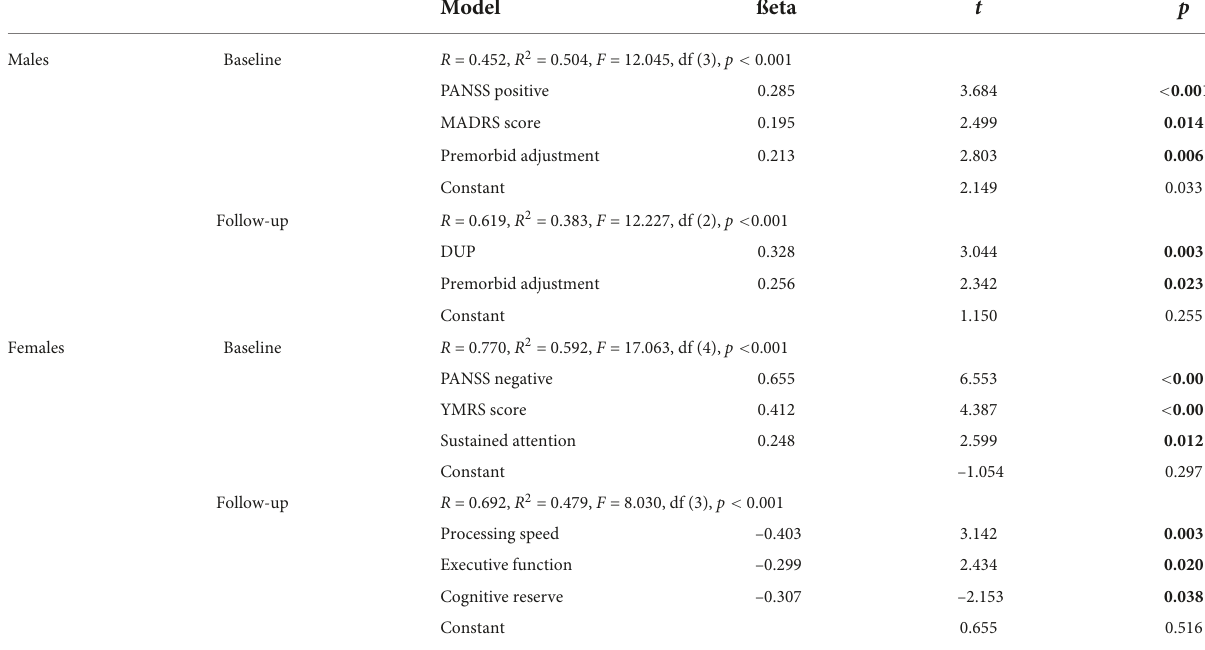
TABLE 4 Linear regression of the socio-demographic, clinical and neuropsychological variables associated with psychosocial functioning in males and females with psychosis. Model